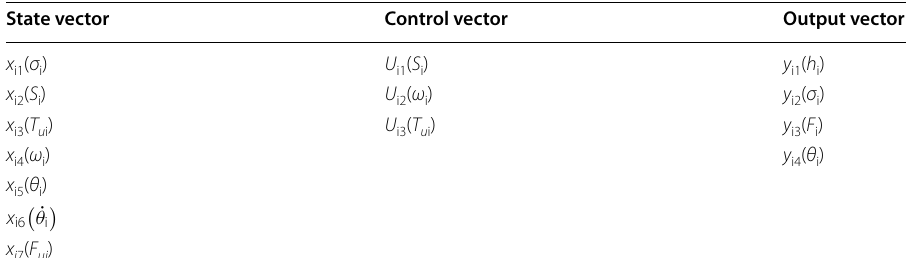
Table 1 Stand# i state, control, and output vectors State vector Control vector